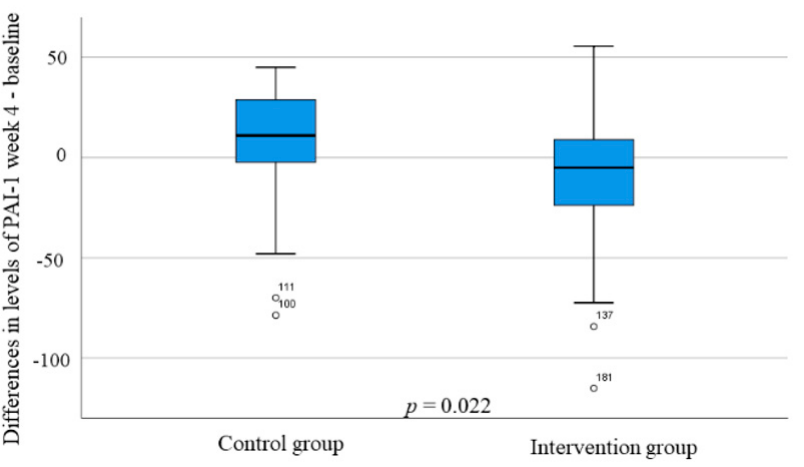
Figure 5. The differences in plasminogen activator inhibitor-1 (PAI-1) (ng/mL) changes during the study between the control and intervention group. Mann–Whitney U-test. p < 0.05 was considered statistically significant.